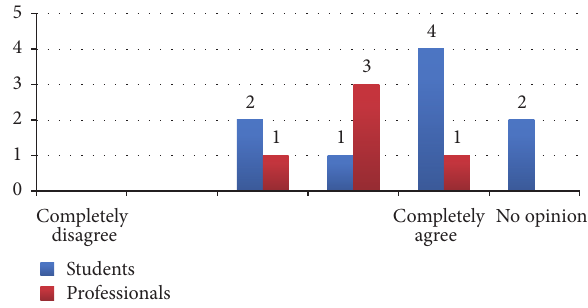
Figure 5: ECW/PUEA is a very good at creating consensus within the group performing it.